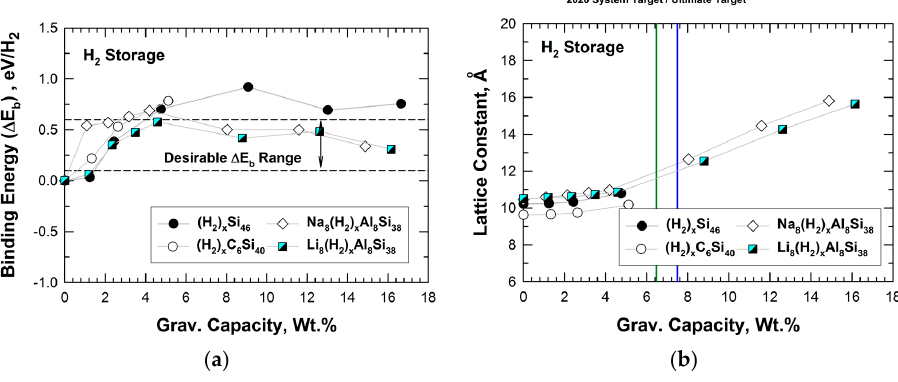
Figure 8. Predicted internal binding energy, lattice constant, and gravimetric capacity of Si 46 , C 6 Si 40 , Na 8 Al 8 Si 38 , and Li 8 Al 8 Si 38 . The range over which binding interactions of H 2 is favorable for room-temperature storage is noted as dashed lines: ( a ) binding energy vs. gravimetric capacity and ( b ) lattice constant vs. gravimetric capacity. From Chan et al. [22]. The vertical green line indicates DOE’s 2020 system target, while the vertical blue line indicates the DOE ultimate fleet target for onboard storage for vehicles. C 2018 , 4 , 7